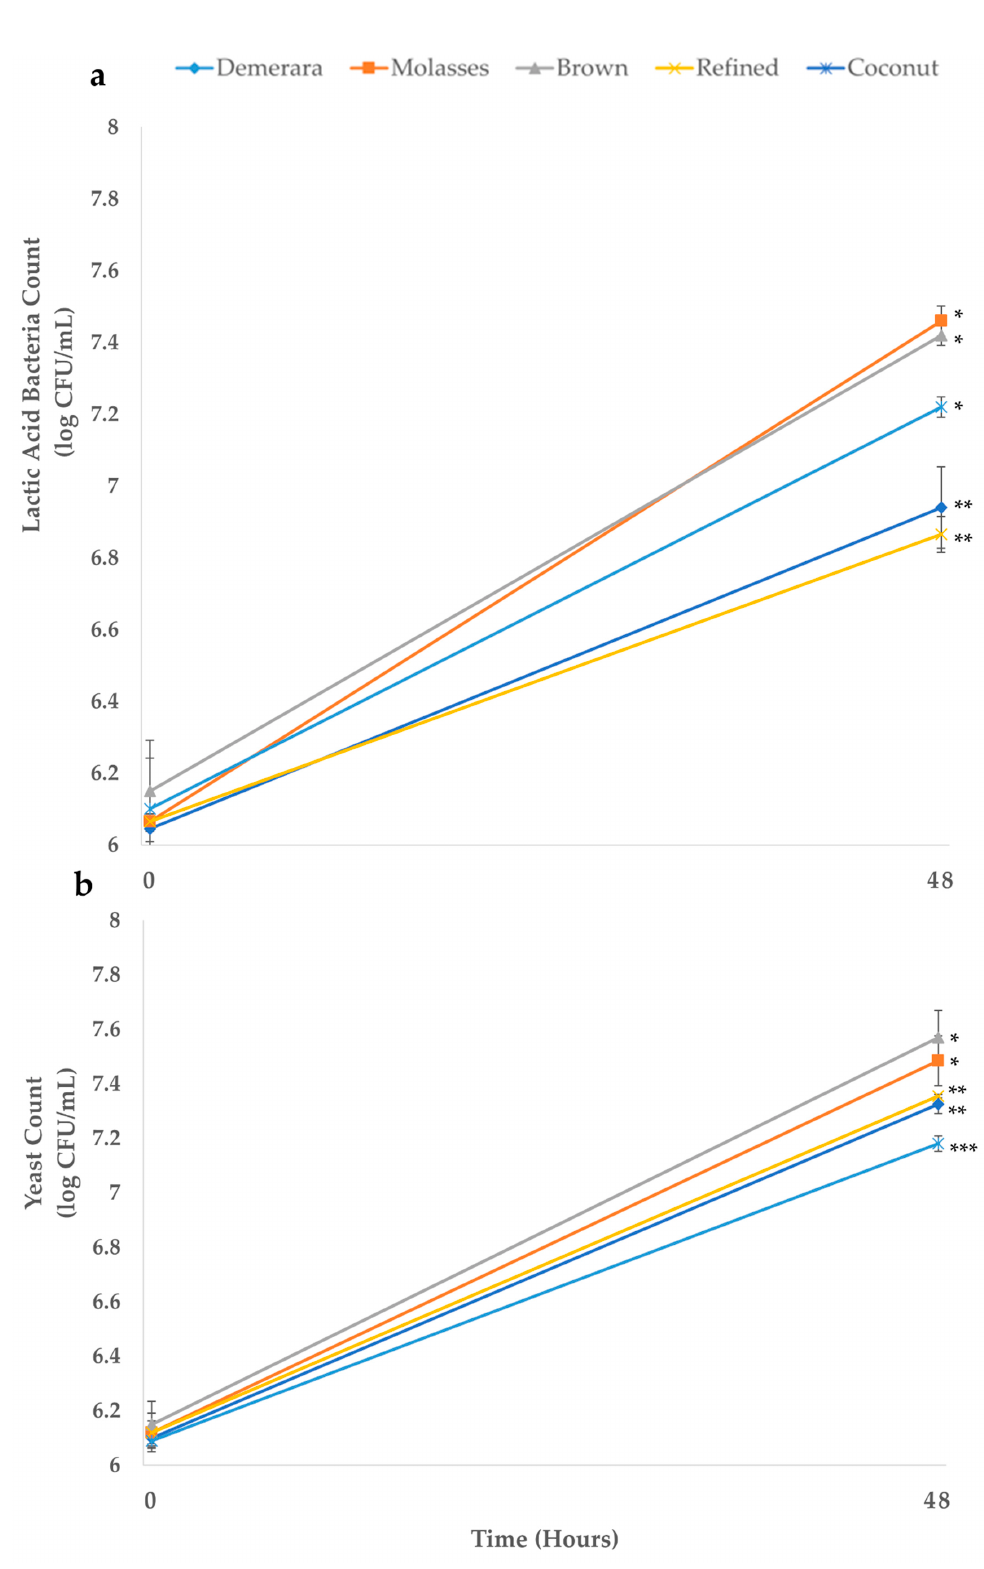
Figure 2. The growth of lactic/acetic acid bacteria ( a ) and yeasts ( b ) during the fermentation process of water kefir grains in different fermentative sugary substrates sugary substrates (Demerara, Molasses, Brown, Refined and Coconut). The asterisks indicate groups without a statistical difference (*, **, or ***), according to the Tukey test performed for the results at 48 h.